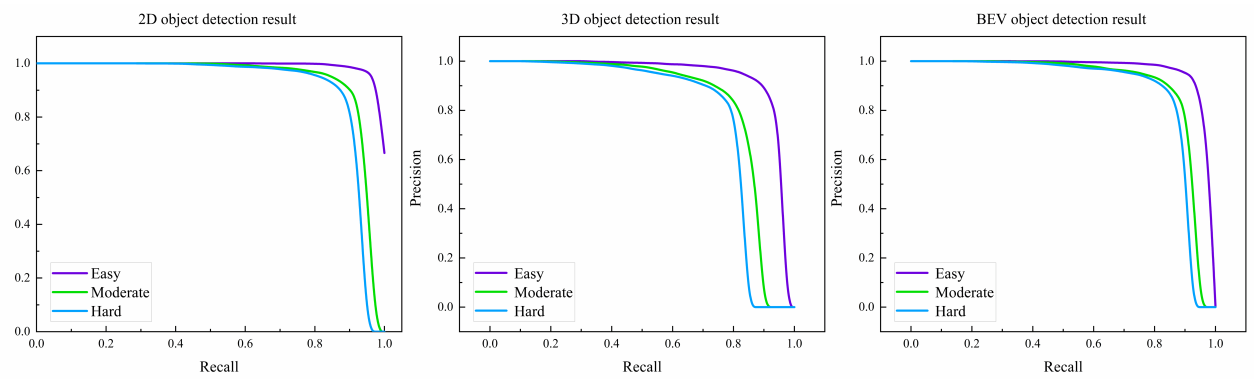
Figure 7. P-R variation curve in multiple viewing angle detection tasks.